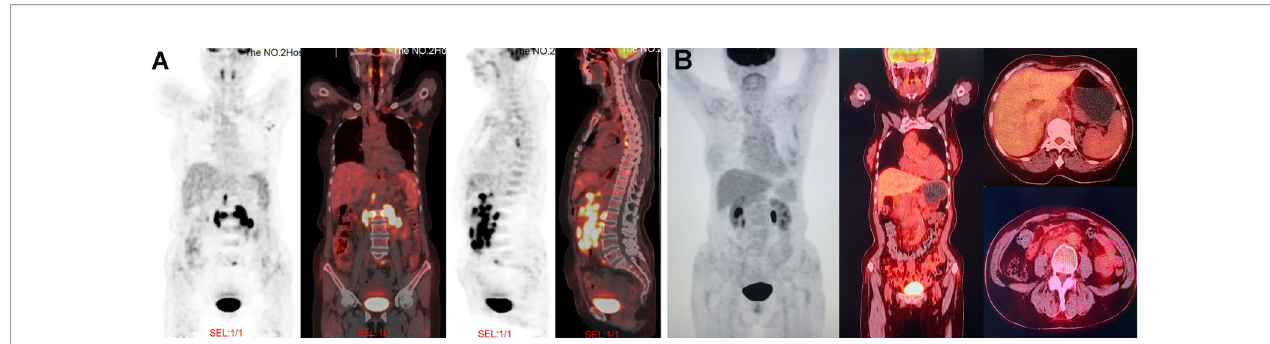
FIGURE 1 | PET/CT images at different time points during treatment. (A) At the time of diagnosis, PET/CT revealed the lymphadenopathy in the mediastinum, left axilla, peritoneal retroperitoneal, bilateral diaphragmatic foot, and left peri-iliac vessels; as well as several nodular FDG-avid lesions in the right scapula with hypermetabolic activity (SUVmax: 7.9). (B) After four cycles of GemOx plus tislelizumab combination treatment, PET/CT revealed that patient achieved complete response.